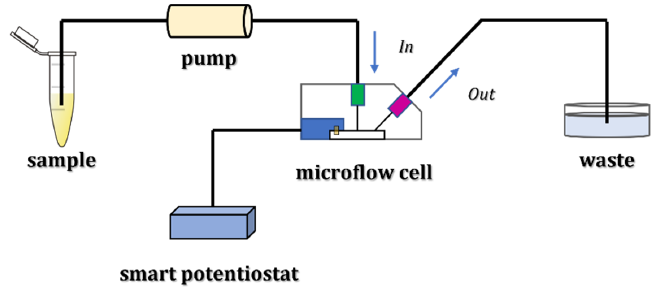
Figure 1. Experimental setup for lithium detection using a microflow configuration.